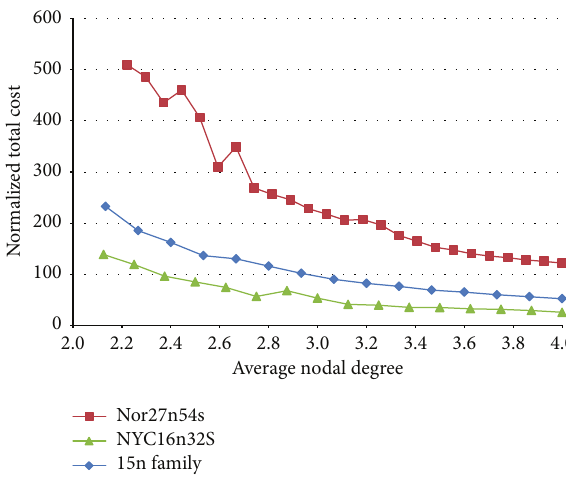
Figure 29: Normalized span restoration JCA costs for network families based on real